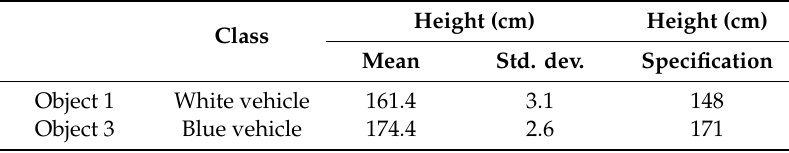
Table 3. Modified object height estimates.